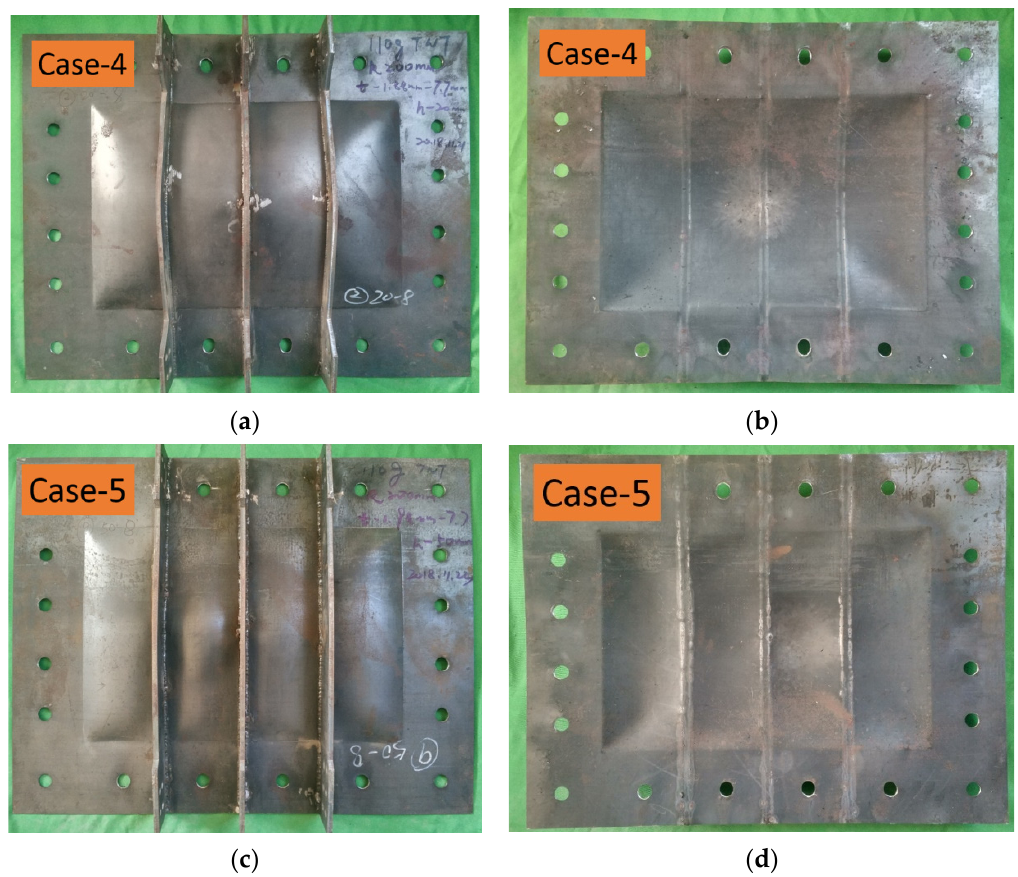
Figure 9. Typical failure modes of the stiffened plates: ( a ) front and ( b ) back view of Test No. 4; ( c ) front and ( d ) back view of Test No. 5.